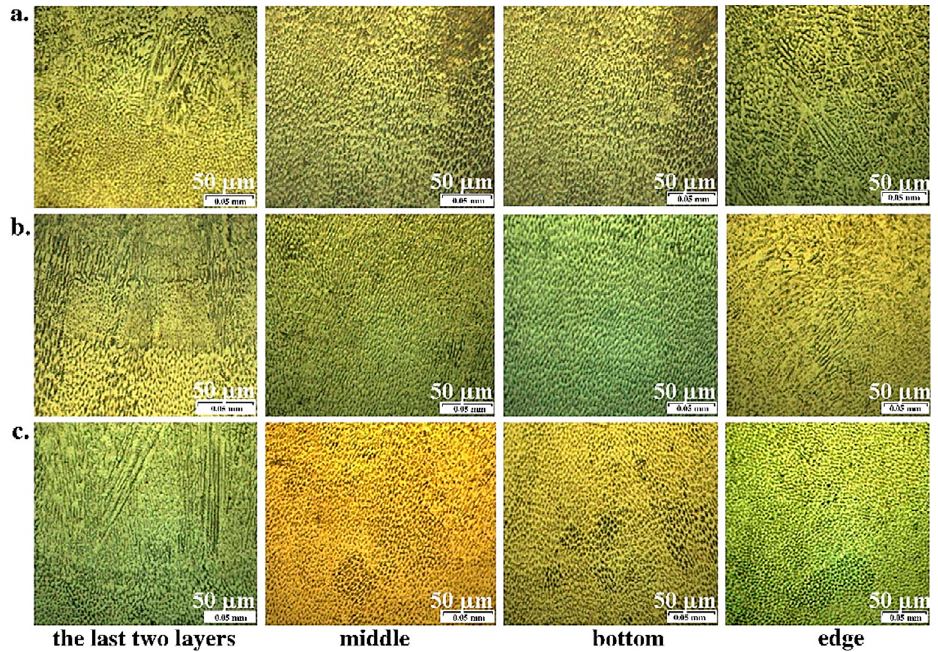
Figure 5. The microstructure of the DED thin walls examined at cross-section and longitudinal section in the middle of the thin wall. a) With a constant laser power of 300 W, b) Process control with a constant set-value 0.5 V and c) Process control with a path-dependent set-value 0.3 V(2 mm)–0.5 V(56 mm)–0.3 V(2 mm) [52].